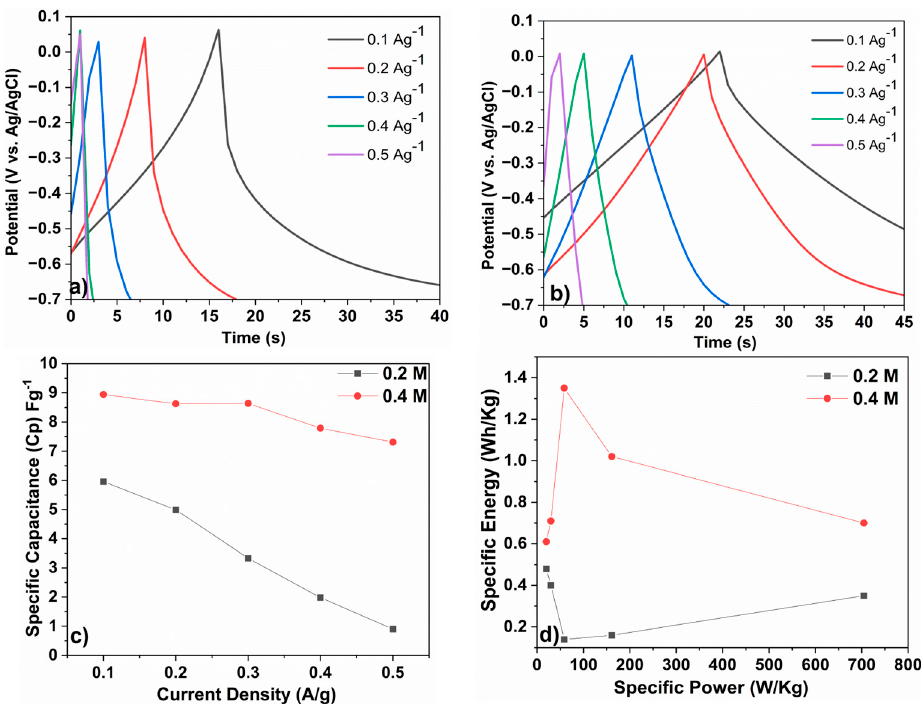
Figure 5. GCD curves of electrodes tested at different current densities for the ( a ) 0.2 M sample and ( b ) 0.4 M sample. ( c ) Specific capacitance of both electrodes at different current densities. ( d ) Ragone plot of both electrodes.